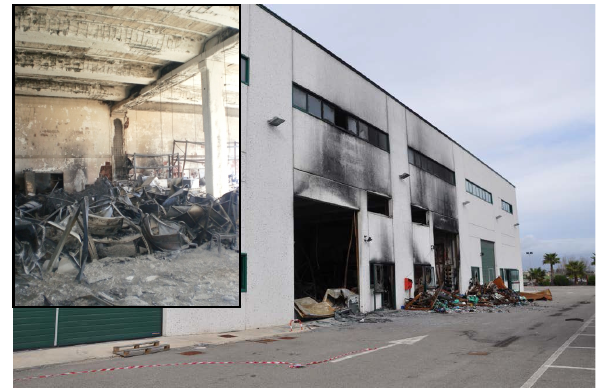
Figure 14: Industrial building